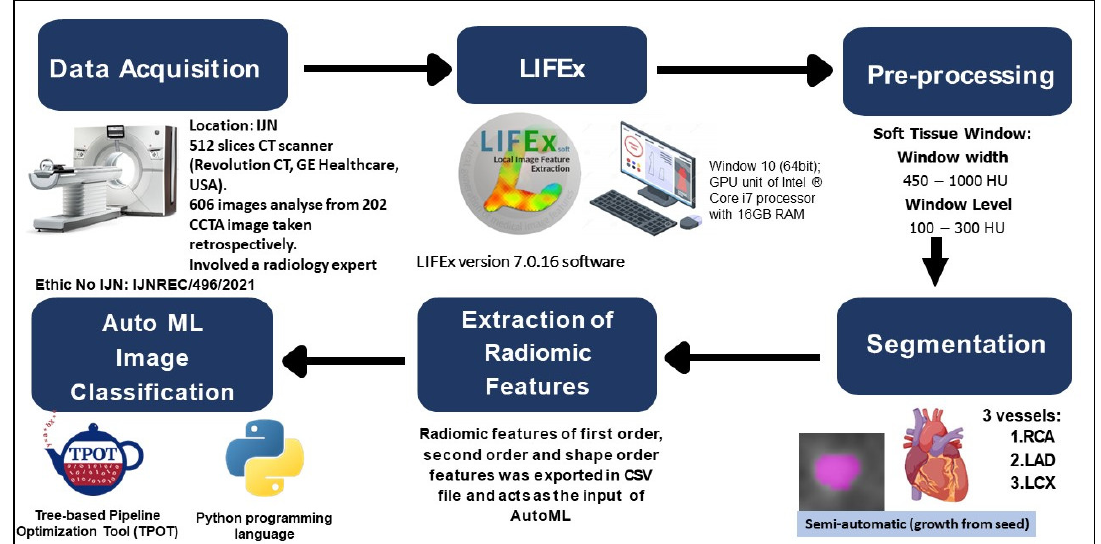
Figure 2. Overall flow of patient selection.